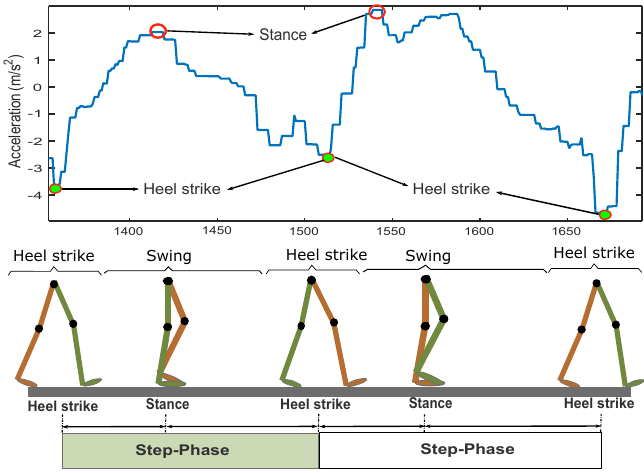
Figure 4. Vertical acceleration based on walking diagram.